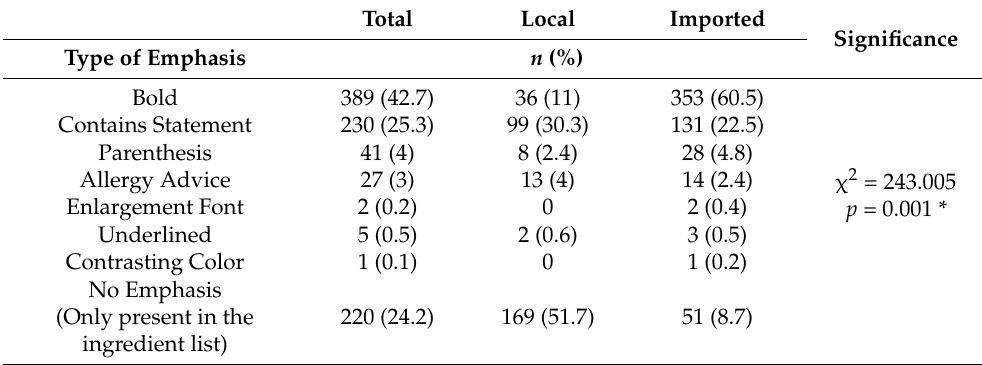
Table 2. Types of emphasis used when declaring allergens on the ingredient